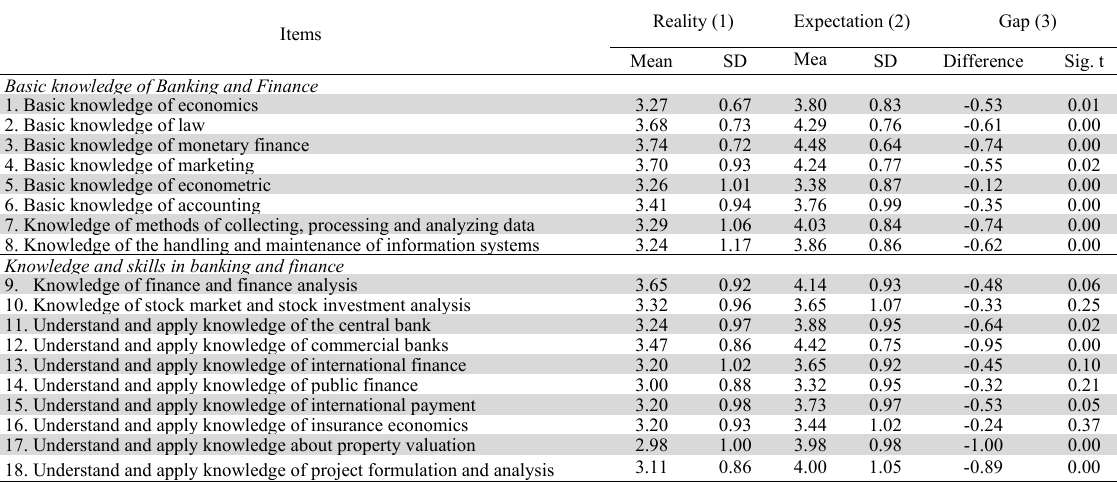
The gap between reality and expectation